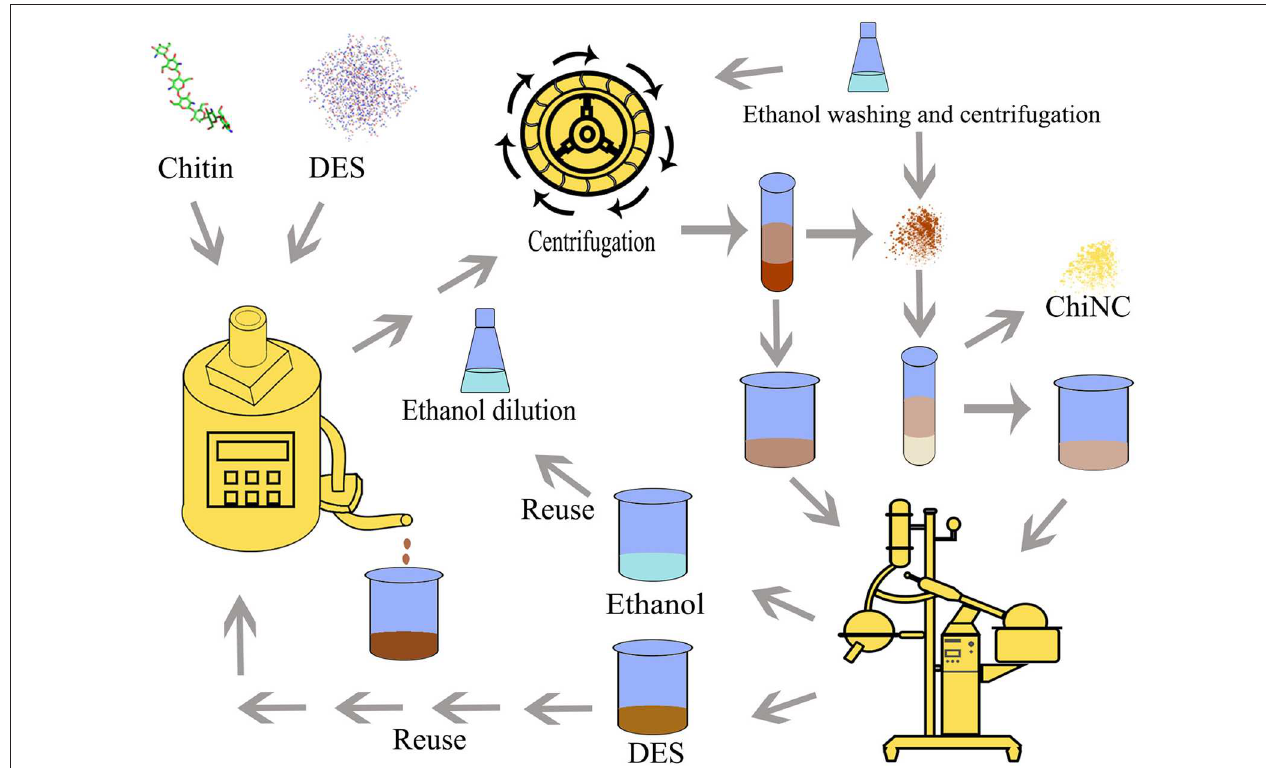
FIGURE 1 | The scheme of the ChiNC preparation process by using DES as